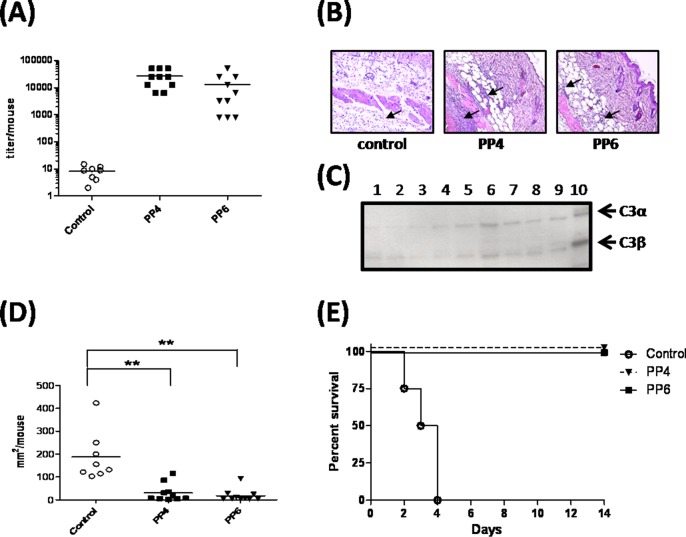
Immunization of synthetic peptides protects mice from M49 GAS strain-induced death.(A) Sera were collected from synthetic peptide PP4- or PP6-immunized mice, and the titers of anti-SPE B antibody were detected by ELISA. (B) Histopathological difference in control mice and peptide-immunized mice after infection with GAS. Groups of 8 to 10 BALB/c mice were immunized with synthetic peptides and inoculated via the air pouch route with 3 × 108 CFU of the M49 GAS strain. Skins around the GAS-infected air pouch were excised, fixed, and stained with H&E reagent at 48 h post-infection. A large number of infiltrated cells were distributed around the connective tissues from the PP4- or PP6-immunized mice but not in tissues from GAS-infected control mice (arrows). (C) Levels of C3 in the air pouch exudates collected from control group (lane 1–3), PP4-immunized mice (lane 4–6) and PP6-immunized mice (lane 7–9) on day 2 after GAS infection. The degradation of C3 by GAS infection was analyzed by Western blot with anti-C3 antibody. Human serum dilute with PBS (1:100) was a positive control for C3 (lane 10). (D) The area of the skin lesions around the air pouch of the GAS-infected mice was estimated at 48 h post-infection. **P< 0.01, compared with the values determined for control group. (E) The survival rates in control or synthetic peptide-immunized mice after infection with M49 GAS. The survival curves were compared for significance using the log-rank test for the immunized mice versus the control group (P< 0.01).